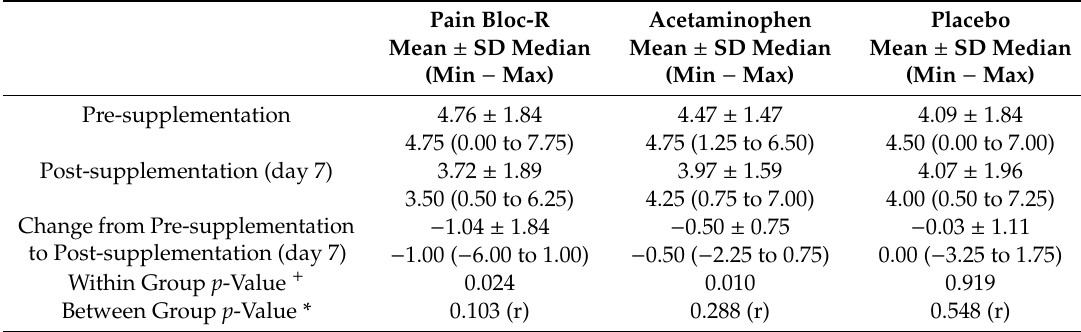
Table 4. The BPI pain severity score and change in pain severity score from pre-supplementation to day 7 in the PP population ( n = 19).